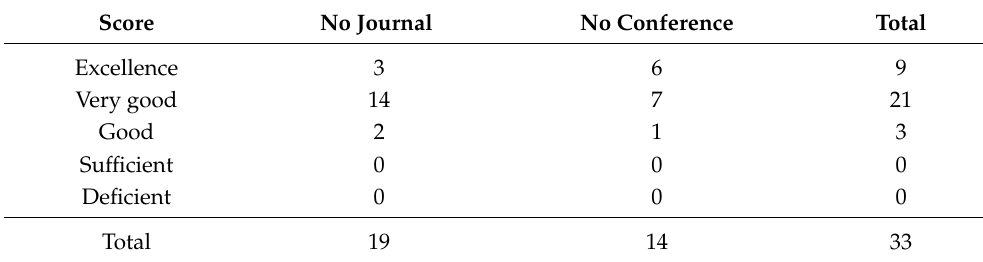
Table 4. Metric result.